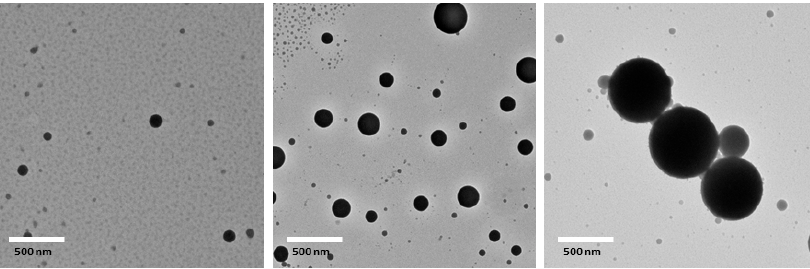
Figure 2. Transmission electron microscopy (TEM) images of three lipid-based emulsions (mean droplet sizes of No. 1, No. 2, and No. 3 are 556, 265, and 170 nm, respectively). All of the data were presented as mean ± standard deviation from at least three measurements.